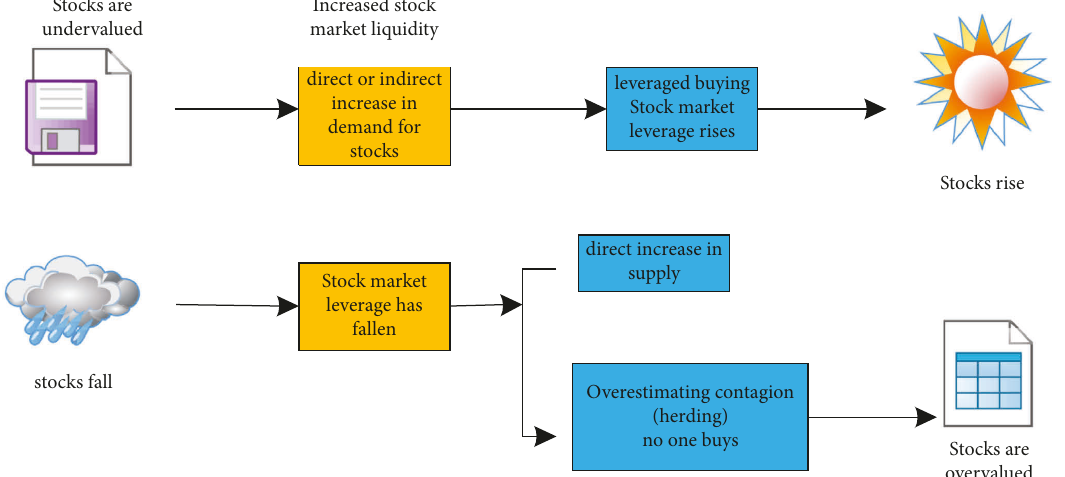
Figure 3: Model of the fluctuation